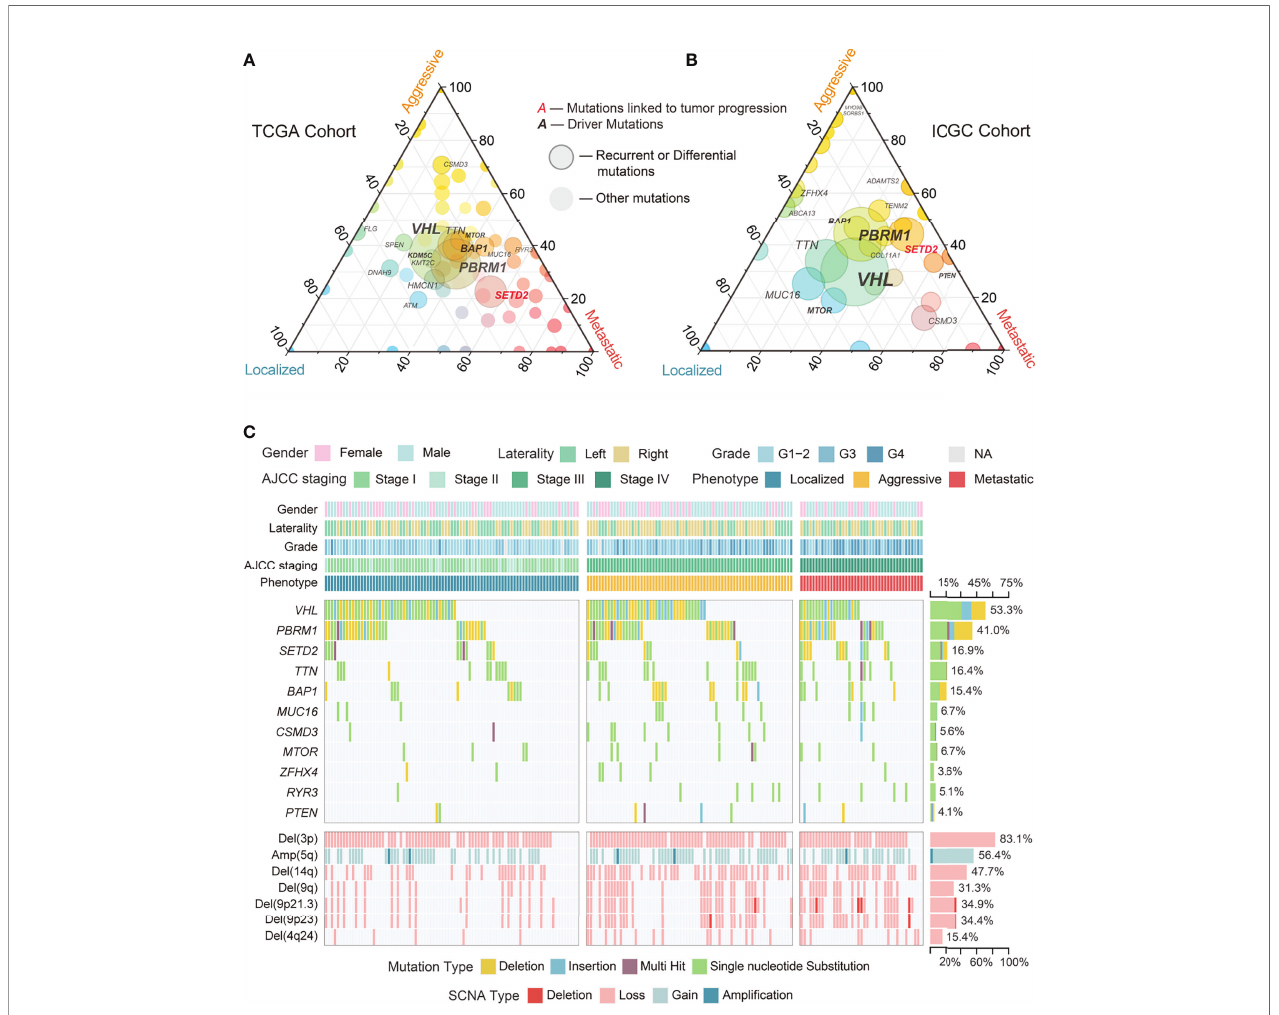
FIGURE 2 | Overview of genomic alterations among phenotypes in ccRCC. (A) Ternary plot showing proportions of mutations among phenotypes of ccRCC in TCGA cohort. (B) Ternary plot showing proportions of mutations among phenotypes of ccRCC in ICGC cohort. (C) Waterfall plot with recurrent and differential mutations and SCNAs among phenotypes of ccRCC in TCGA